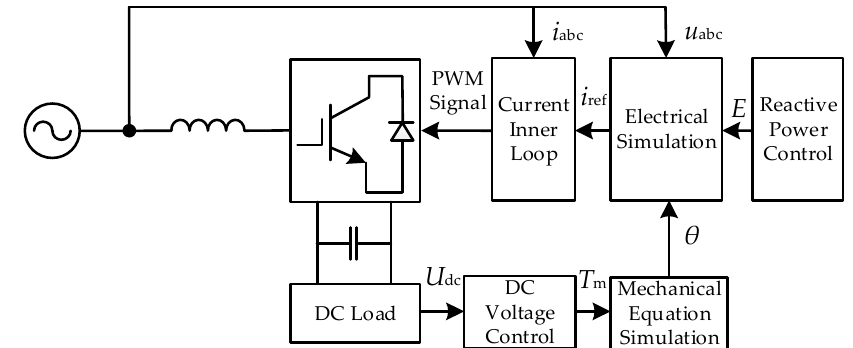
Figure 8. The scheme of the modeled systems. Table 1. Simulation parameters.